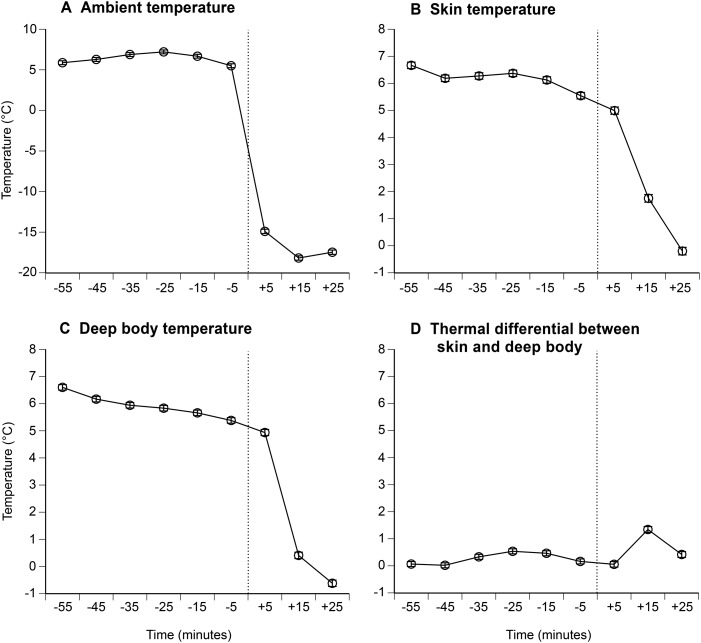
Rates of cooling on the skin surface and inside the body for cane toads (Rhinella marina) transferred from a refrigerator to a freezer. The panels show (A) ambient temperatures during the trials, (B) skin-surface temperatures, (C) deep-body temperatures, and (D) the thermal differential between the skin surface and the body core (means and standard errors). X-axis shows midpoint time for each 10-min period.